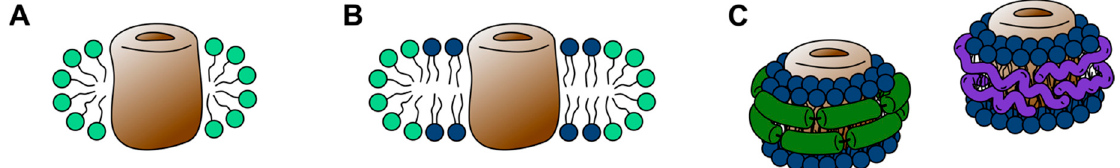
Figure 1. Solubilized states of membrane proteins. ( A ) Membrane protein in a detergent micelle (cyan). ( B ) Membrane protein in a disc-shaped bicelle containing lipids (blue). ( C ) Membrane proteins in nanodiscs stabilized by membrane scaffold protein (MSP, green) and amphipathic polymers (purple).